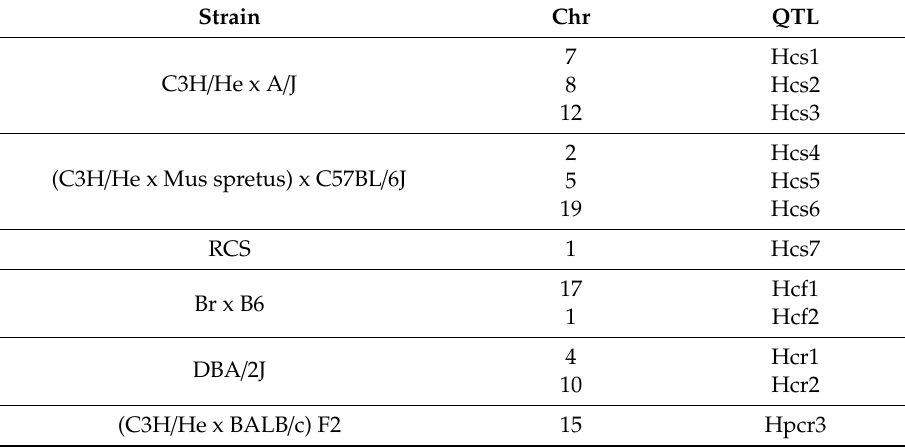
Table 1. QTLs regulating HCC development in